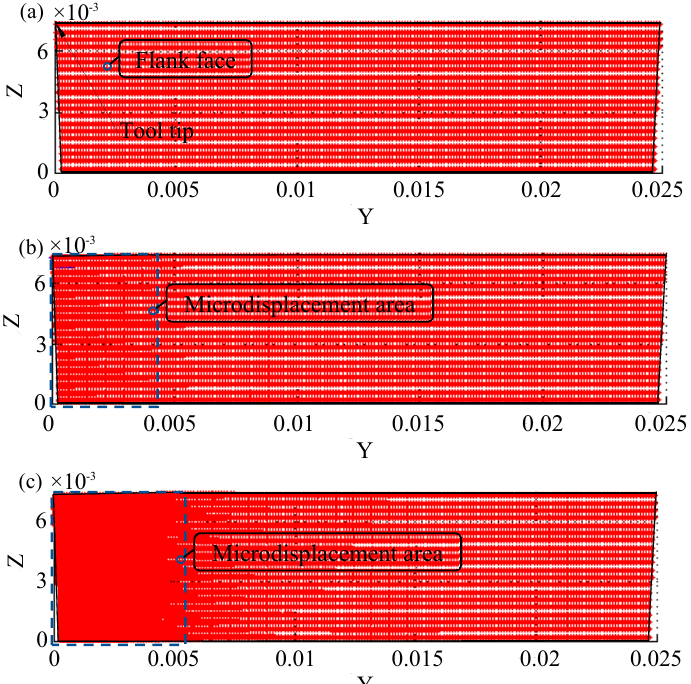
Figure 13. Position evolution in the main cutting direction of material points of the CCMTT: ( a ) the first step of PD analysis of the CCMTT (initial state), ( b ) the 2000th step of PD analysis of the CCMTT (microdisplacement), ( c ) the 3500th step of PD analysis of the CCMTT (further microdisplacement).